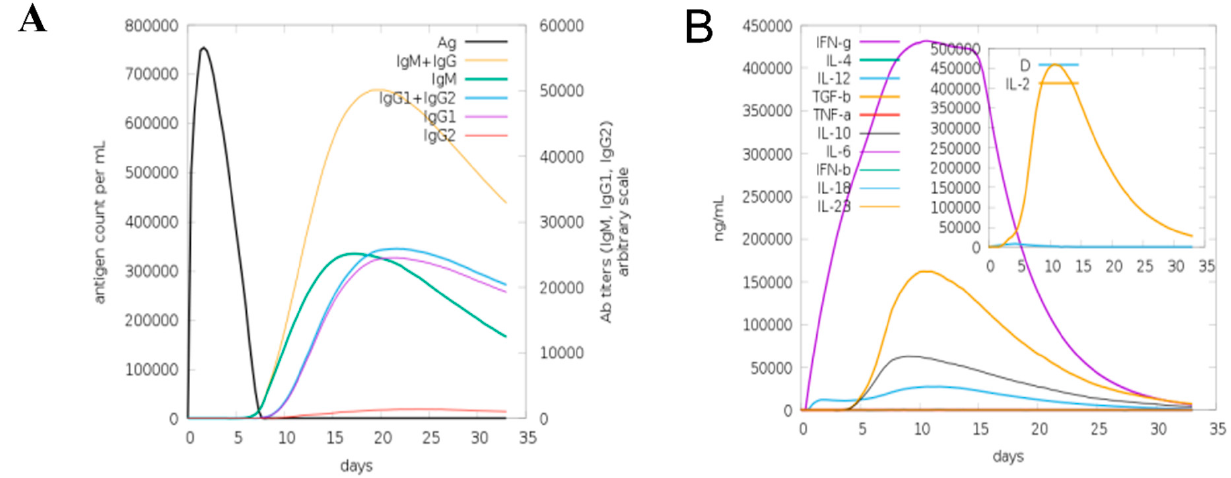
Figure 6. Computational immune simulation of host immune system against designed vaccine. ( A ) Computational immune simulation graph showing immunoglobulins production. ( B ) Graph showing the induction of cytokines and interleukins. Table 4. Top models of docked complexes of designed vaccine with TLR4.